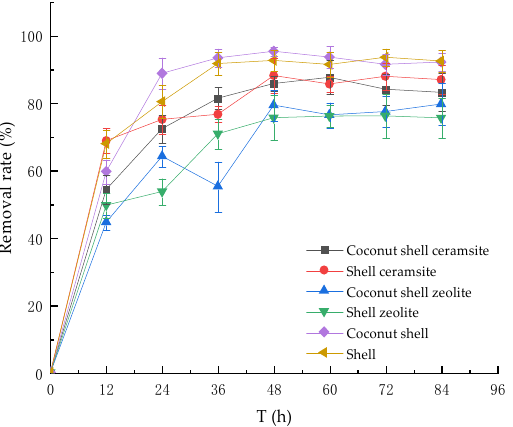
Figure 4. Removal effect of biochar-constructed wetland on ammonia nitrogen.